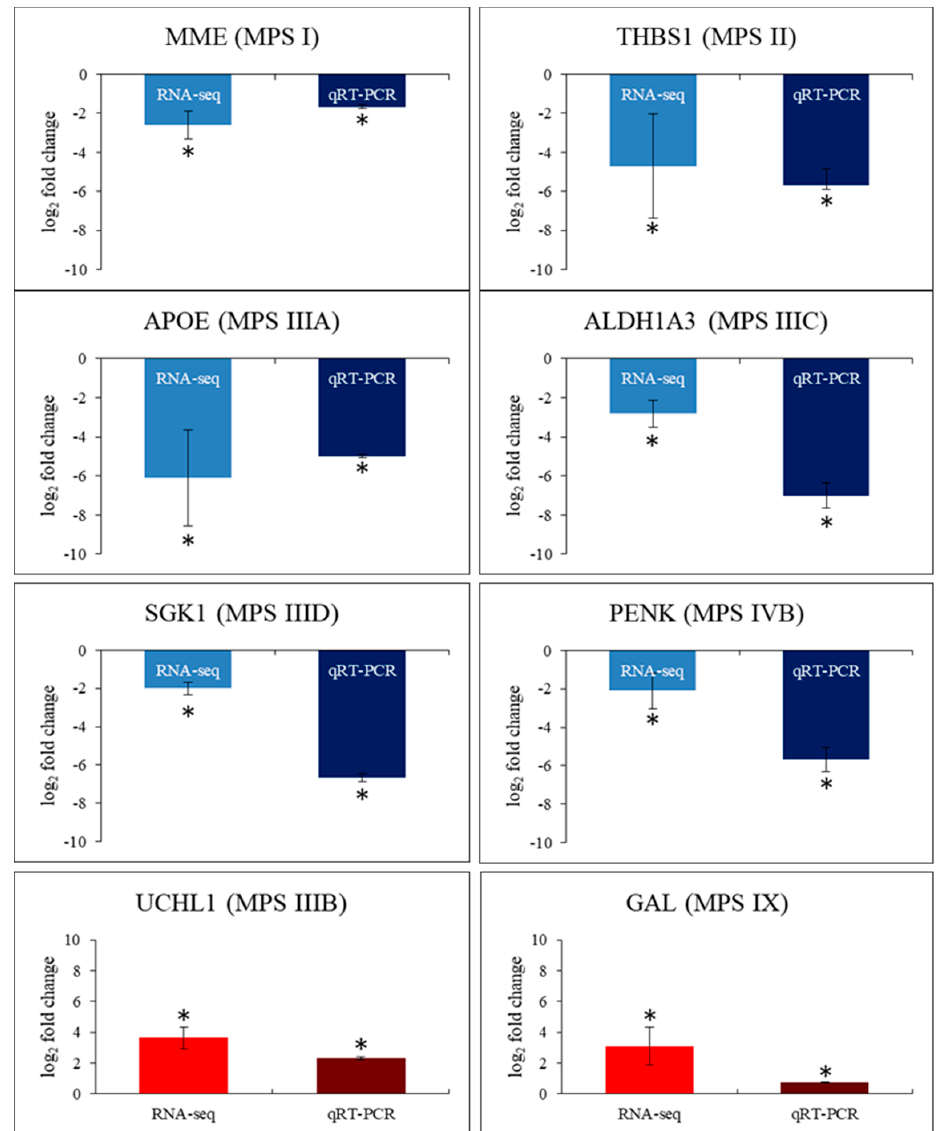
Figure 7. Comparison of results of assessing levels of transcripts using RNA-seq and RT-qPCR methods, obtained for selected genes in all tested MPS types/subtypes relative to control cell line (HDFa). One gene was tested in each MPS type/subtype as indicated in the figure. Presented values are mean values from 4 experiments with SD shown as error bars. Statistically significant differences relative to control (HDFa) cells are indicated by asterisks.